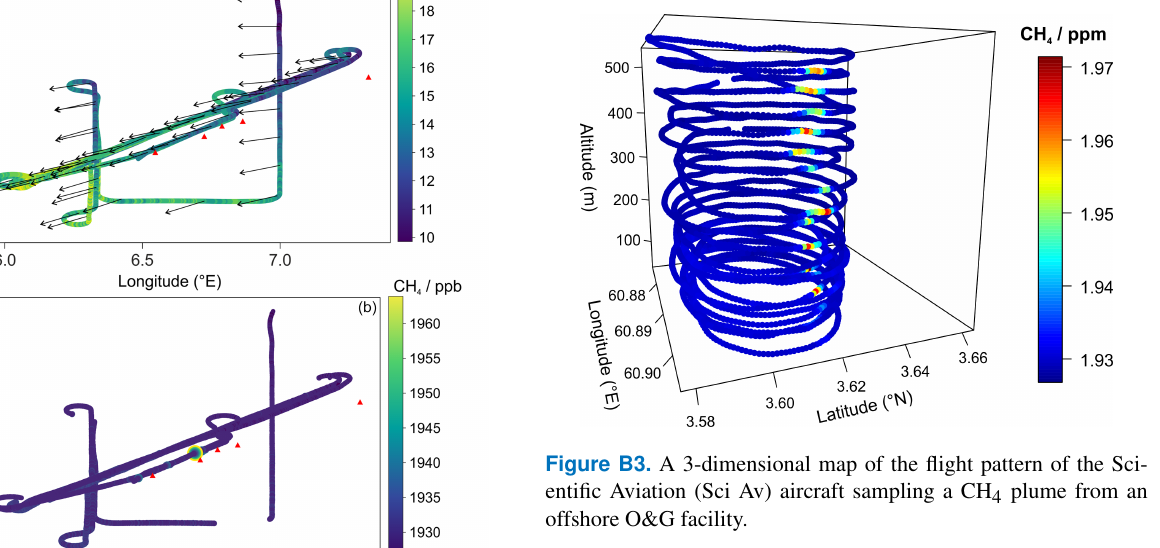
Figure B2. Altitude–longitude projection of the vertically stacked downwind transects conducted in flight C193, coloured by the CH 4 mixing ratios.